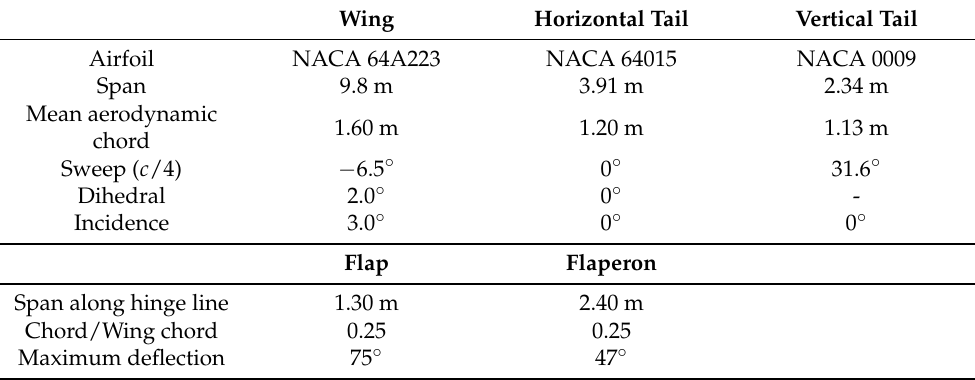
Table 3. Geometrical characteristics of the XV-15 full vehicle numerical model. Wing Horizontal Tail Vertical